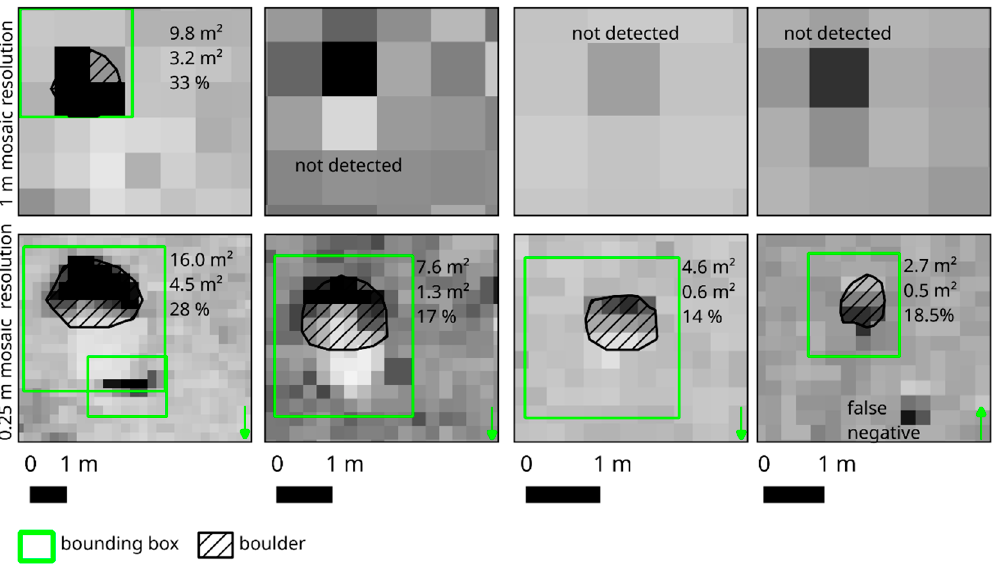
Figure 9. Relationship between area of different bounding boxes (upper number) and estimated area actually covered by boulders (lower number) for 1 m and 0.25 m mosaics. Although variable, the area covered by boulders represents 20% of the bounding box on average. Arrows indicate the direction of insonification.